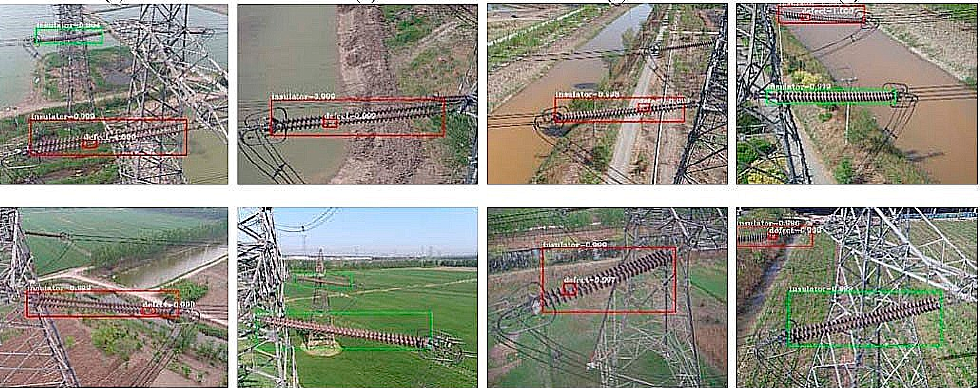
Figure 4. The results of insulator defect detection. The green box represents the non-defective insulator, and the red box represents the defective insulator [39].